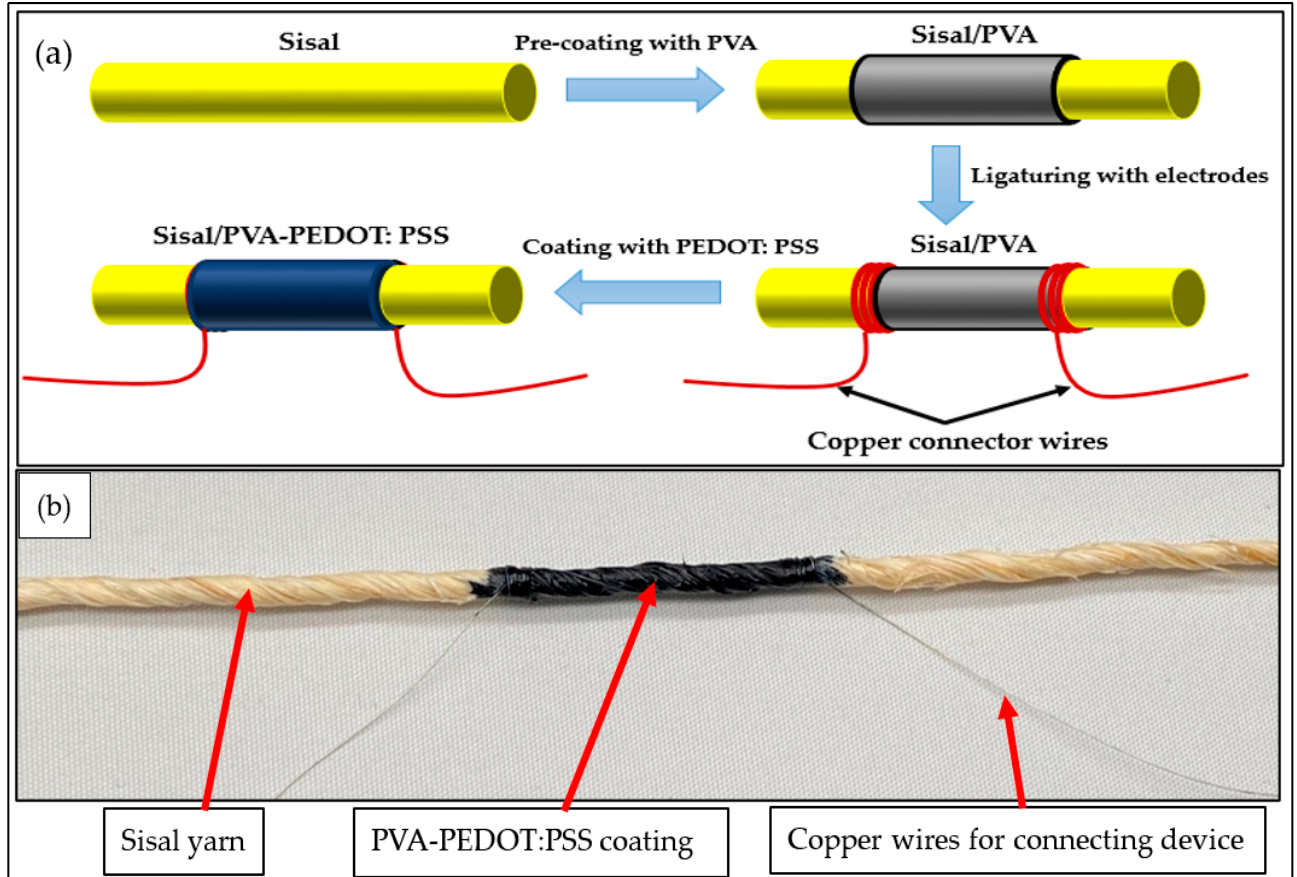
Figure 1. ( a ) Description of the fabrication process steps; ( b ) strain-sensor yarn.